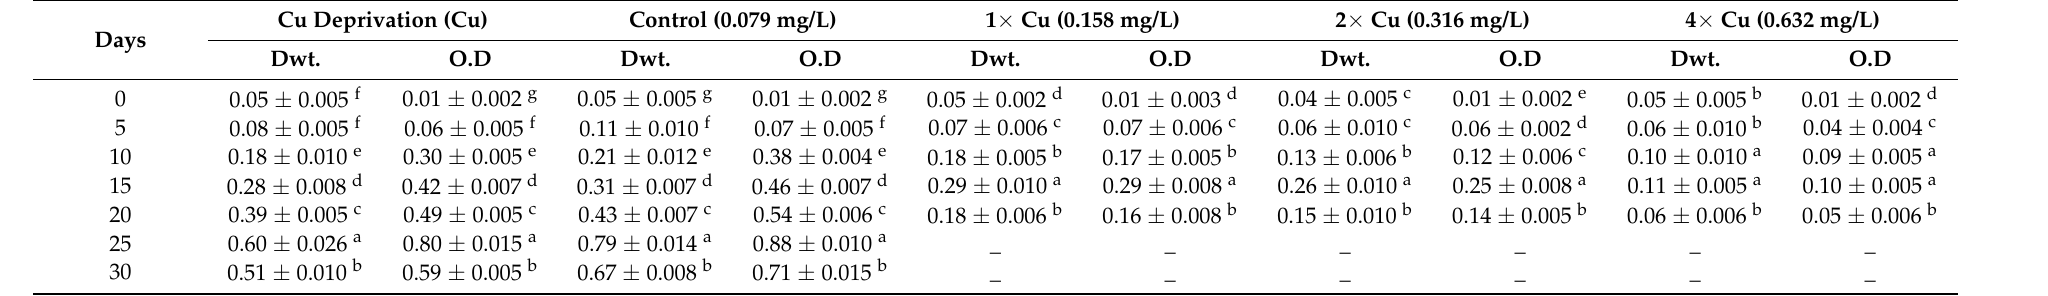
Table 3. Growth rate of Nostoc linckia (as O.D and Dwt). (g/L) grown under various concentrations of copper ion.